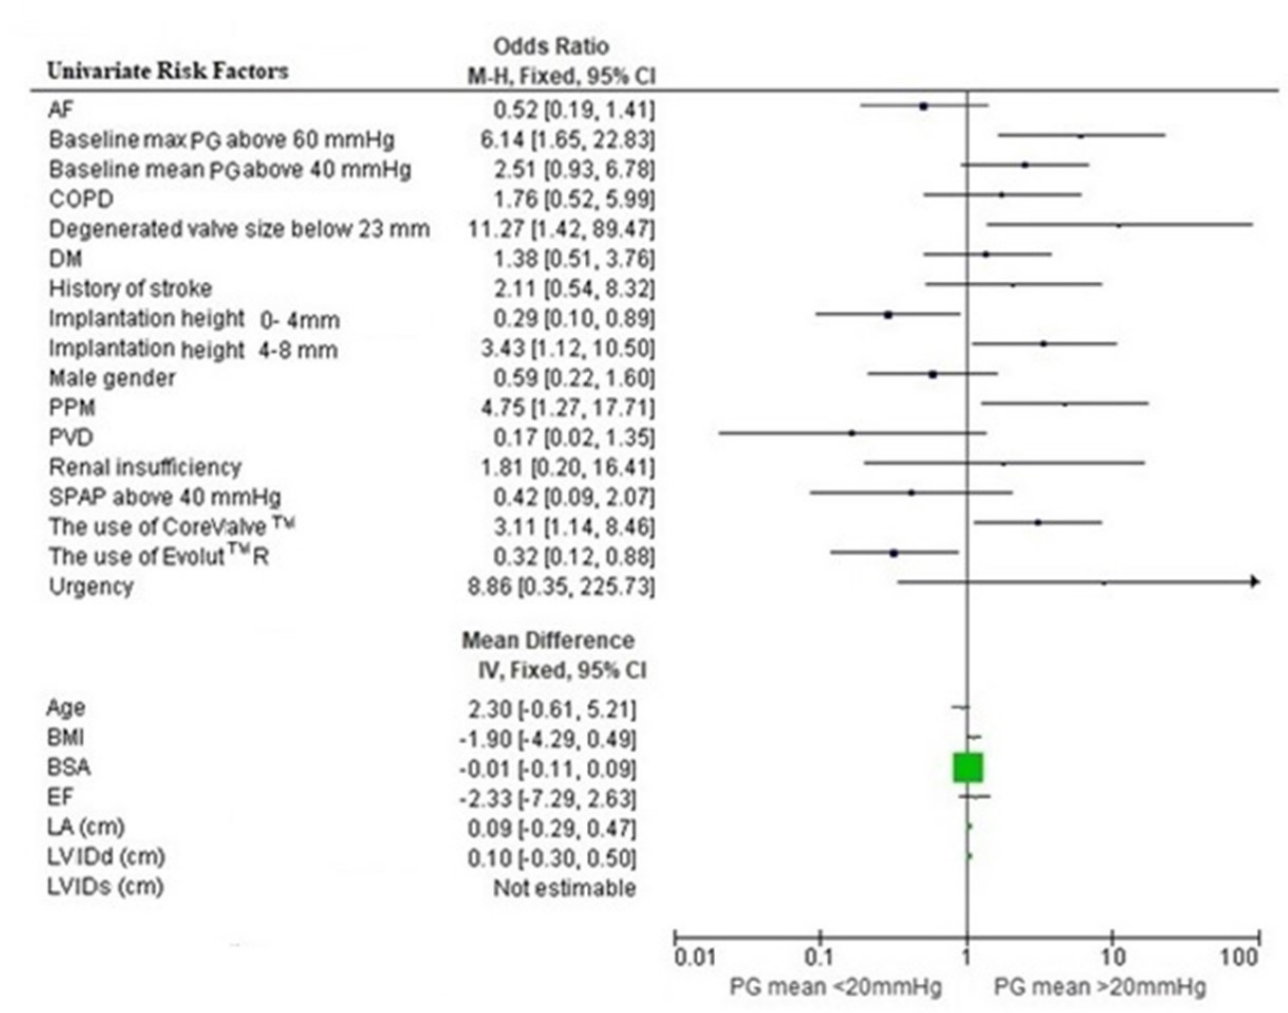
Fig. 1 - Univariate analysis of factors associated with high residual gradients after transcatheter aortic valve-in-valve implantation (by forest plot